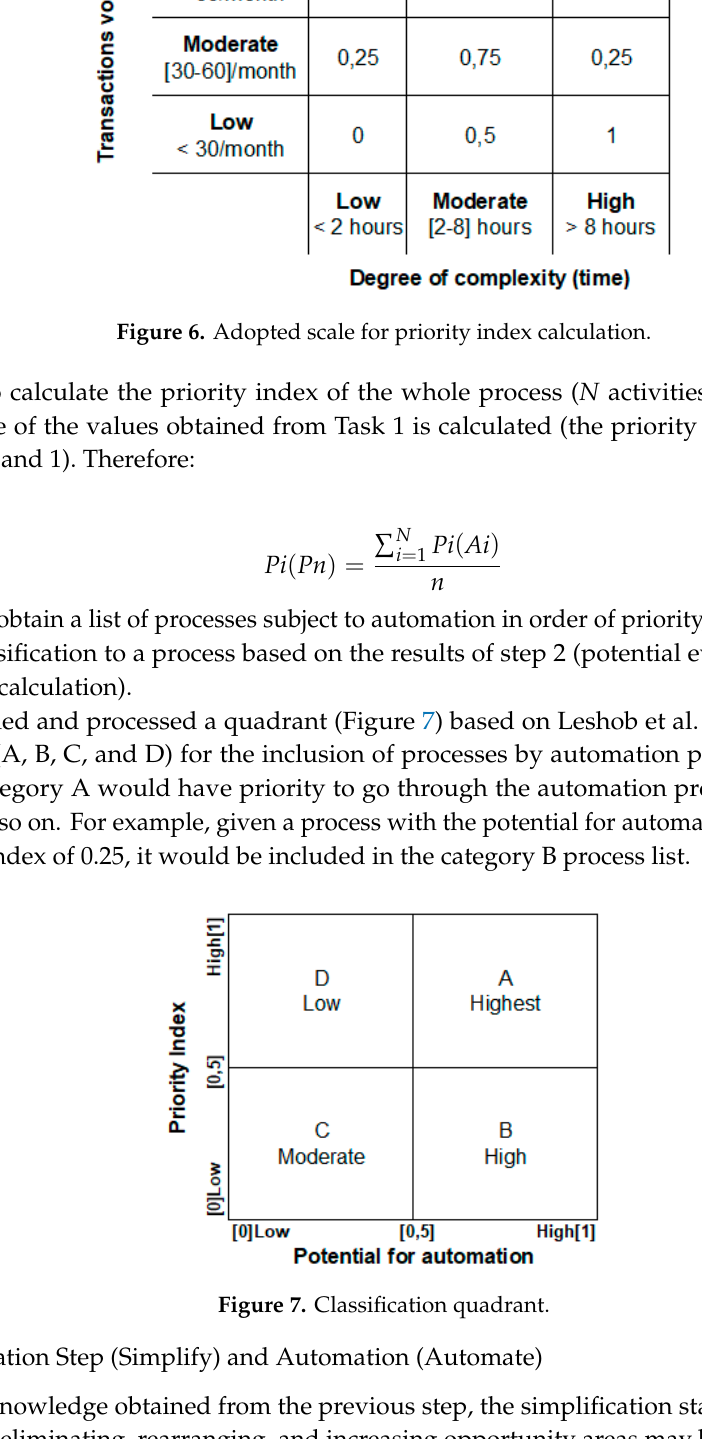
Table 7. Primary areas for simplification and adopted questions examples.